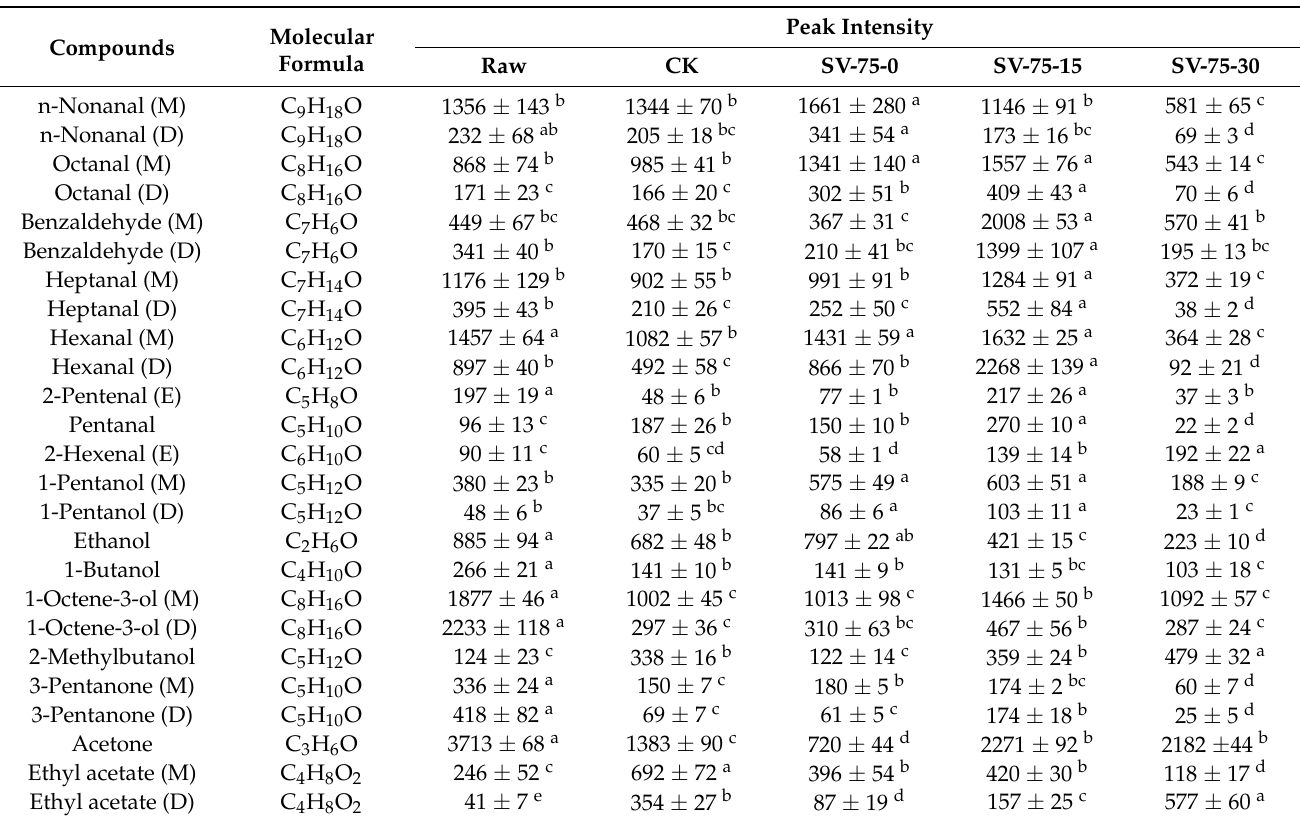
Table 2. The volatile organic compounds (except for the unidentified compounds) in scallop muscle with different